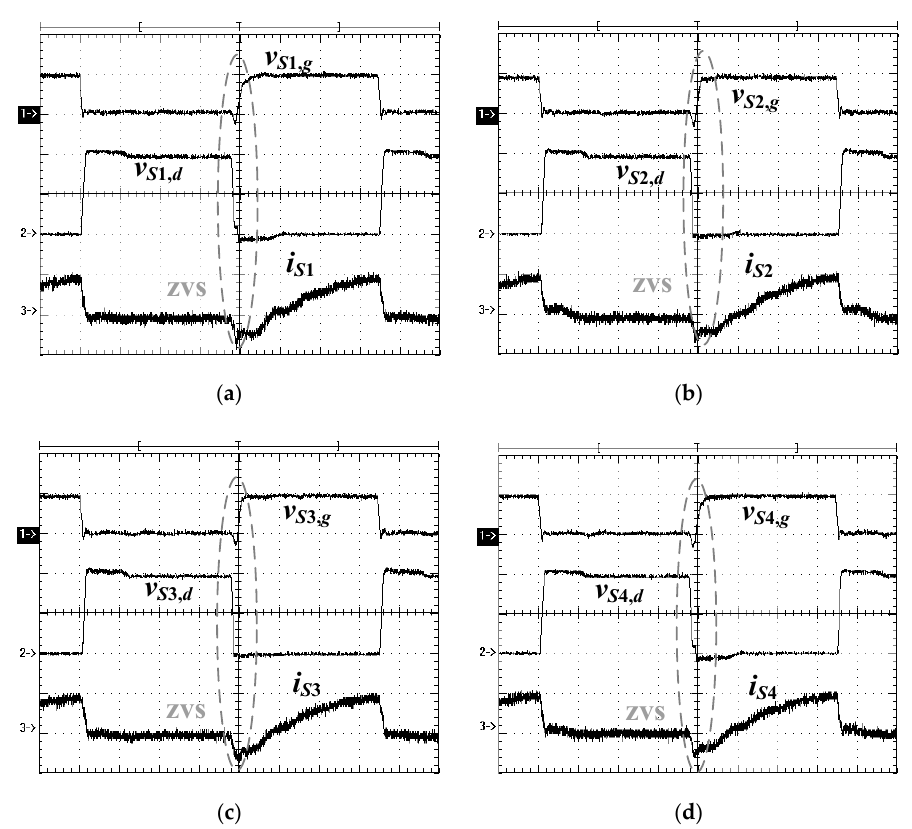
Figure 10. Measured PWM waveforms of S 1 – S 4 at 20% load ( a ) S 1 waveforms ( b ) S 2 waveform ( c ) S 3 waveform ( d ) S 4 waveform (v S1 , g – v S 4, g : 10 V/div; v S 1, d – v S 4, d : 200 V/div; i S 1 ~ i S 4 : 2 A/div; time: 1 μ s).